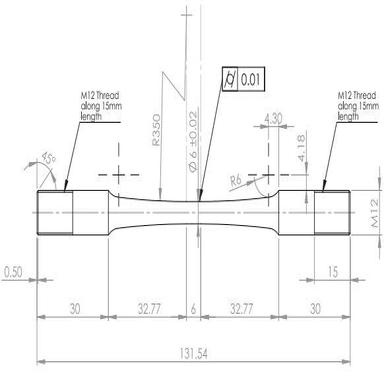
HGR6 specimen geometry.